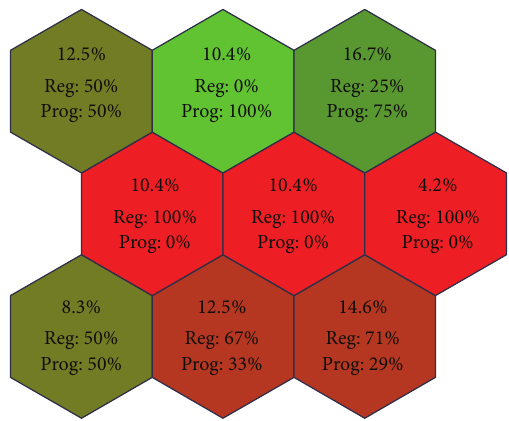
Figure 3: Kohonen self-organizing map (SOM) for a whole gene expression data set in BAL cells obtained from patients with sarcoidosis. Clustering shows the ratio of occurrence (given as % of patients/neuron) of two classes (progression and regression) in individual neurons (green neurons for patients with progression, red neurons for patients with regression; neurons classifying both classes are visualized as interpolation between red and green colors). The bold numbers indicate % of sarcoidosis patients clustered into particular